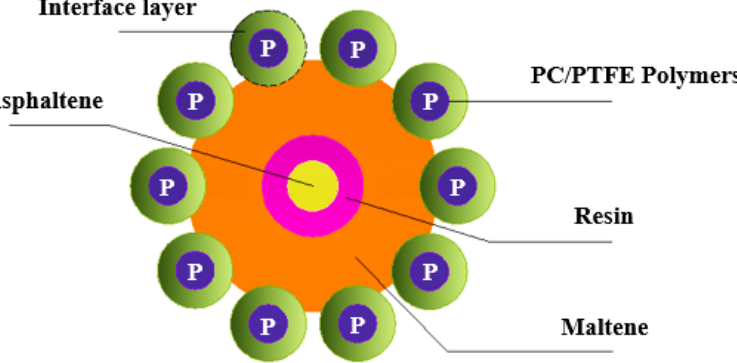
Figure 20. A plausible interaction mechanism between bitumen and PC/PTFE polymers.